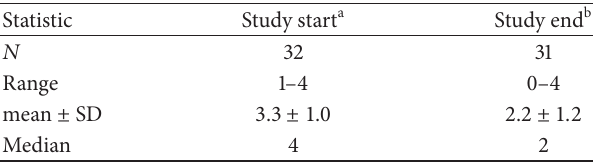
Table 5: Number of symptoms reported at beginning and end of